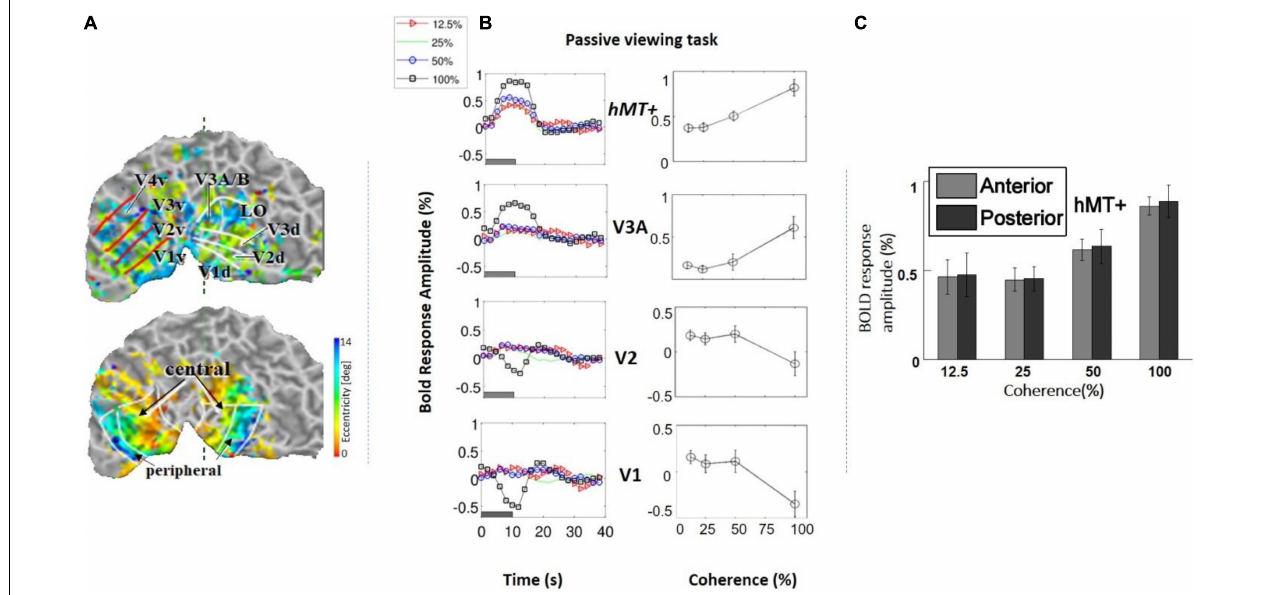
FIGURE 3 | (A) Top: Example of a retinotopic map presented on the flattened visual cortex of a subject. The lines define the borders between visual areas. Bottom: Example of an eccentricity map. The foveal (central) and peripheral ROIs in V1, V2, and V3 are indicated by the black arrows. (B) Left: Average BOLD signal intensity responses as a function of time in four subjects across four motion coherence levels (12.5, 25, 50, 100%) in visual areas V1, V2, V3A, hV5/MT+, while fixating (no motion discrimination task). The baseline BOLD activity elicited by 0% coherence was subtracted (see section “Materials and Methods”). Right : BOLD response amplitude as a function of motion coherence (see section “Materials and Methods”) in the passive viewing condition, across four subjects. Error bars represent the standard error of the mean. (C) Selecting the anterior and posterior voxels of hV5/MT+ did not show any difference in coherence dependence. Therefore, we grouped them together for analysis as the hV5/MT+ complex.